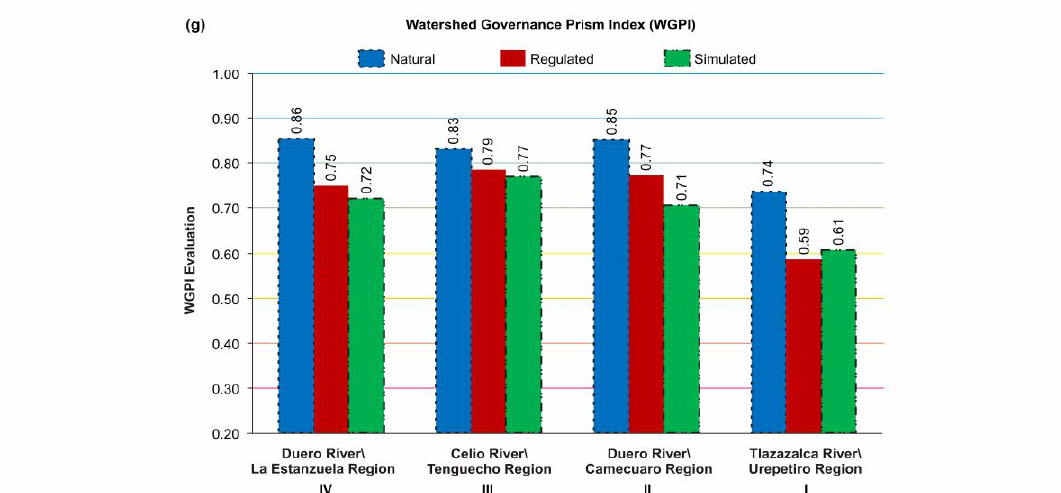
Figure 7. ( a – c ) The results of each of the six axes of the prism through the proposed evaluation of the axis index (AI) comprising the links between the four vertices (watersheds, ecosystems, social systems, and health and well-being) for evaluation in the natural (1936 – 1955), regulated (1956 – 1999), and simulated periods (2000 – 2070). ( d – f ) The numerical evaluation of the Perspective Index (integrated by the AI). Additionally, ( g ) is the total evaluation of the Watershed Governance Prism Index (WGPI) for each of the four regions of influence (Urepetiro, Camecuaro, Tenguecho, and La Estanzuela), with an evaluation of the index in natural, regulated, and simulated periods. Modified Rating Scale [52]. (Categorical values: 1.00≥, ≥0.91—good condition; 0.90≥, ≥0.81—acceptable; 0.80≥, ≥0.61—marginal; 0.60≥, ≥0.41—inadequate; 0.40≥ unacceptable.) Source: own elaboration.